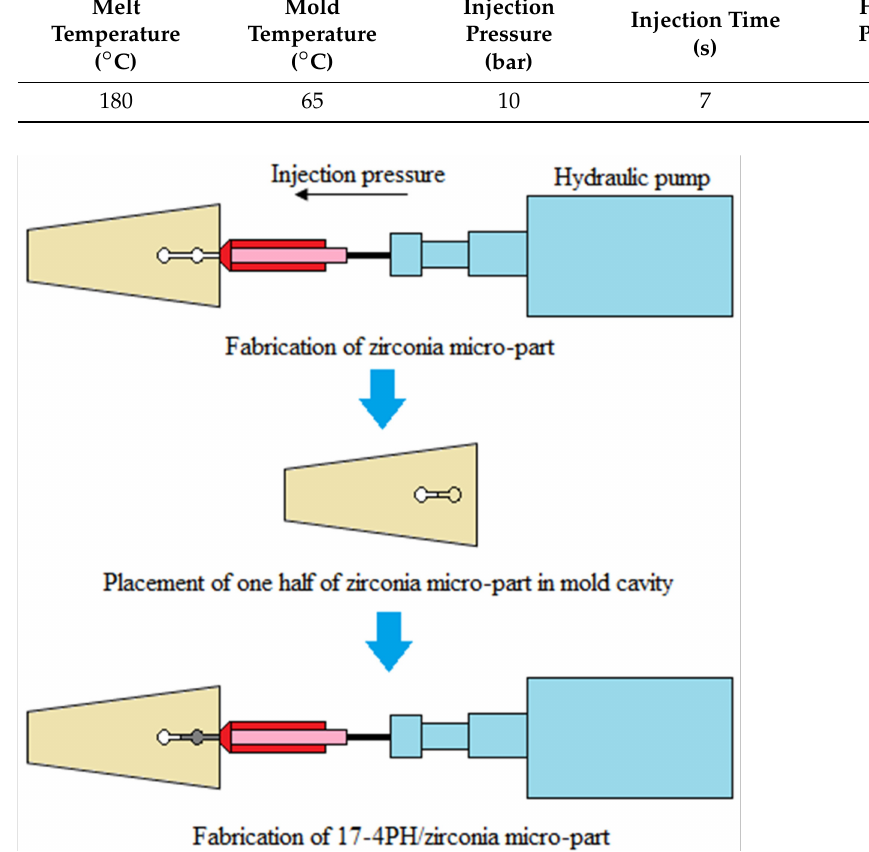
Figure 2. Schematic of the processing method used to produce the green micro-sized 17-4PH/zirconia component, reused with permission from Elsevier [18].